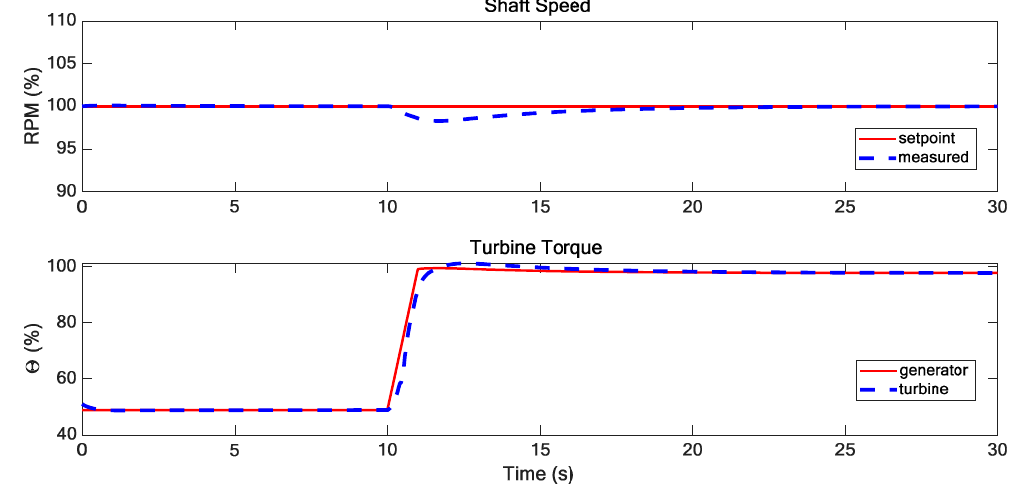
Figure 9. Closed-loop response to rising step.